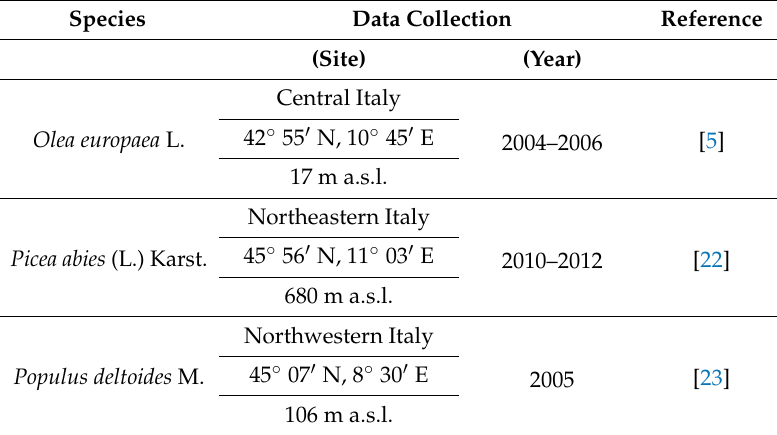
Table 2. Species used for the data collection of stem diameter variation through.